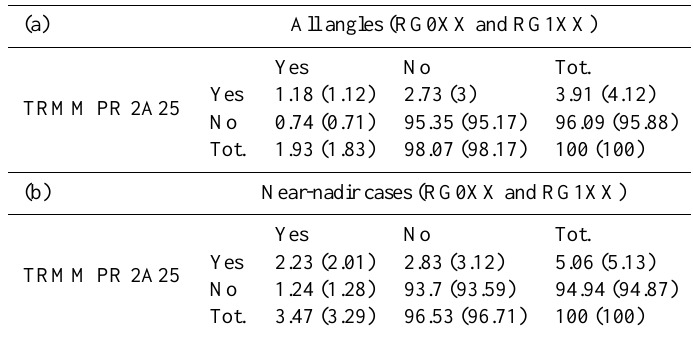
Table 3. Rainfall detection metrics for TRMM 2A25 V7 (V6) compared to RG observations as a function of timescale (10, 20, 30, 60min) during June 2008–May 2011. Note the definitions of the skill scores are provided below. Y indicates positive detection; N indicates no detection.